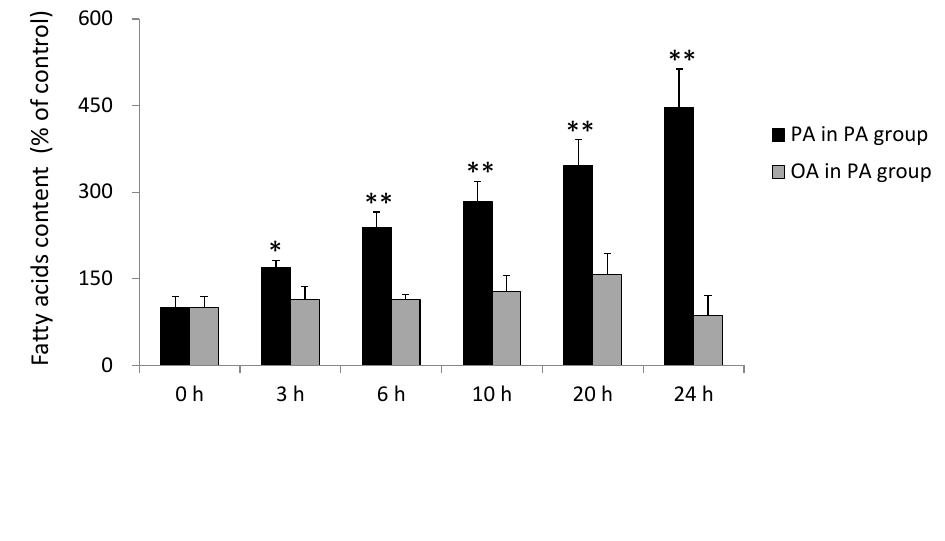
Figure 1. Relative fatty acid contents of SH-SY5Y cells treated with palmitic acid (PA) or oleic acid (OA) at 0, 3, 6, 10, 20 and 24 h. The fatty acid composition was analyzed by gas chromatography after 0~24 h of incubation with ( A ) 0.3 mM PA and ( B ) 0.3 mM OA. Data were analyzed by a one-way analysis of variance (ANOVA), followed by the LSD test, and are presented as the mean ± SD. * p < 0.05, ** p < 0.01 vs. the control group ( n =